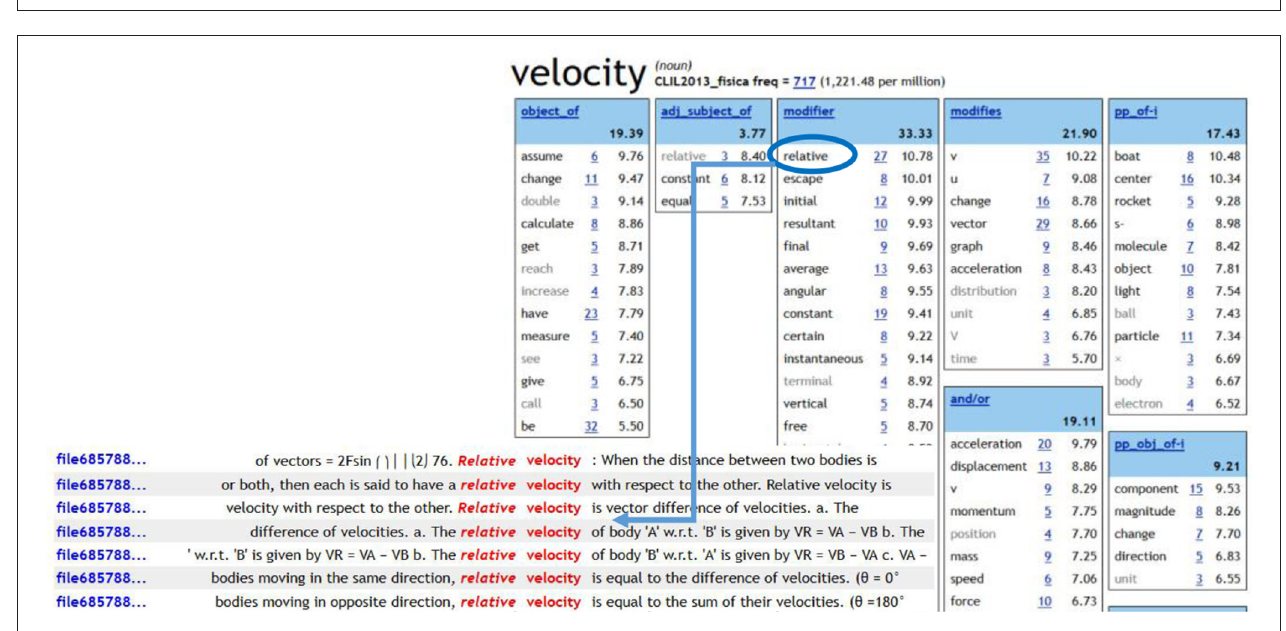
FIGURE 2 | Word sketch and KWIC of velocity (from Sketch